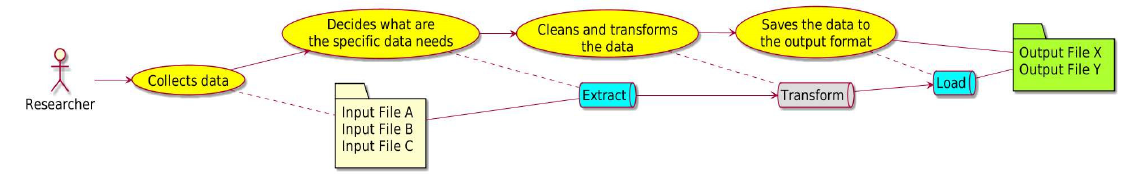
Figure 3. Research data preprocessing viewed as an extract-transform and load (ETL) process.